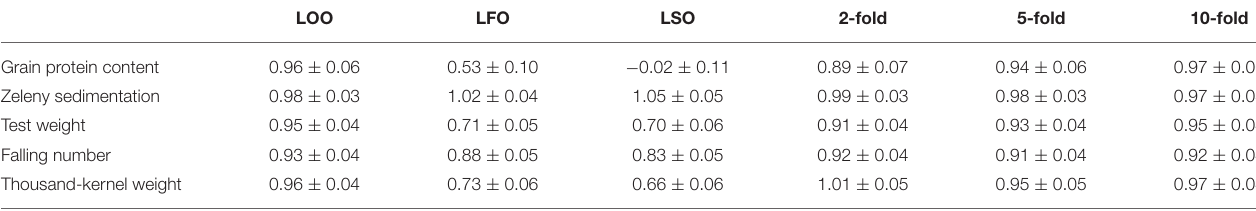
TABLE 7 | Regressions of corrected phenotypes on GEBVs and their standard errors based on different cross-validations strategies using the GBLUP models.